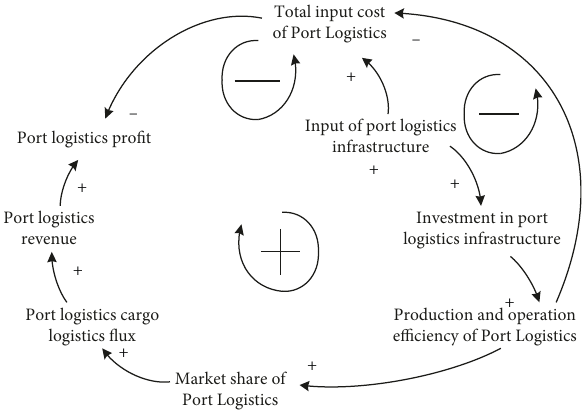
Figure 1: Comprehensive evaluation model of port logistics